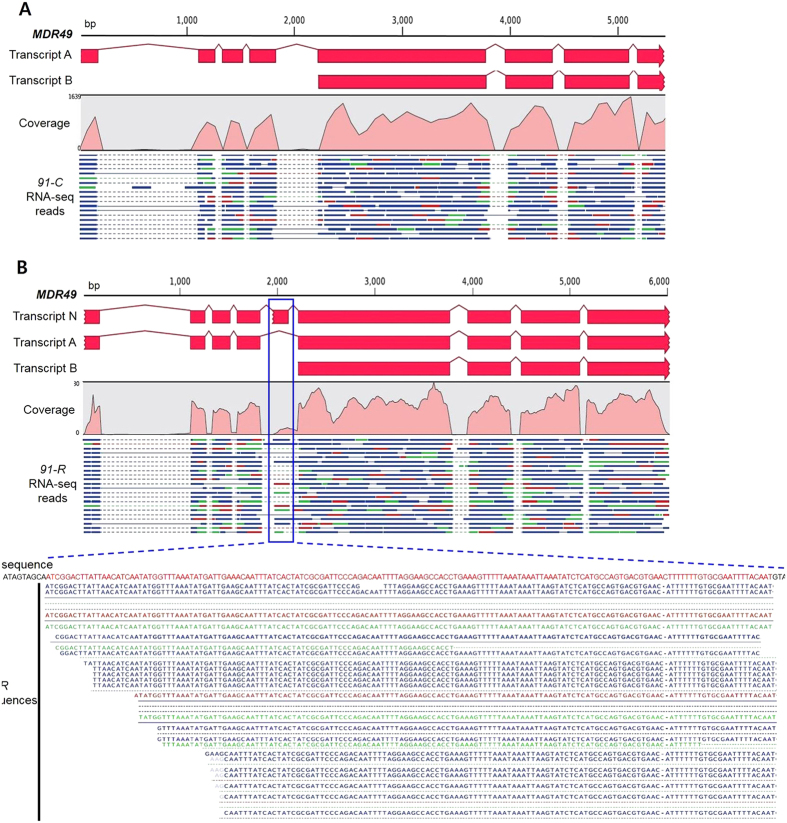
Prediction of MDR49 alternative splice variants.(A) Two alternative splice variants (transcripts A and B) were predicted from 91-C-MDR49. (B) Three alternative splice variants (transcripts A, B and N) were predicted from 91-R-MDR49. Optional exon (transcript N) was indicated by blue box from 91-R-MDR49. Several reads uniquely matched to the non-coding RNA region. Black letters represent exonic region; red letters represent non-coding RNA region.